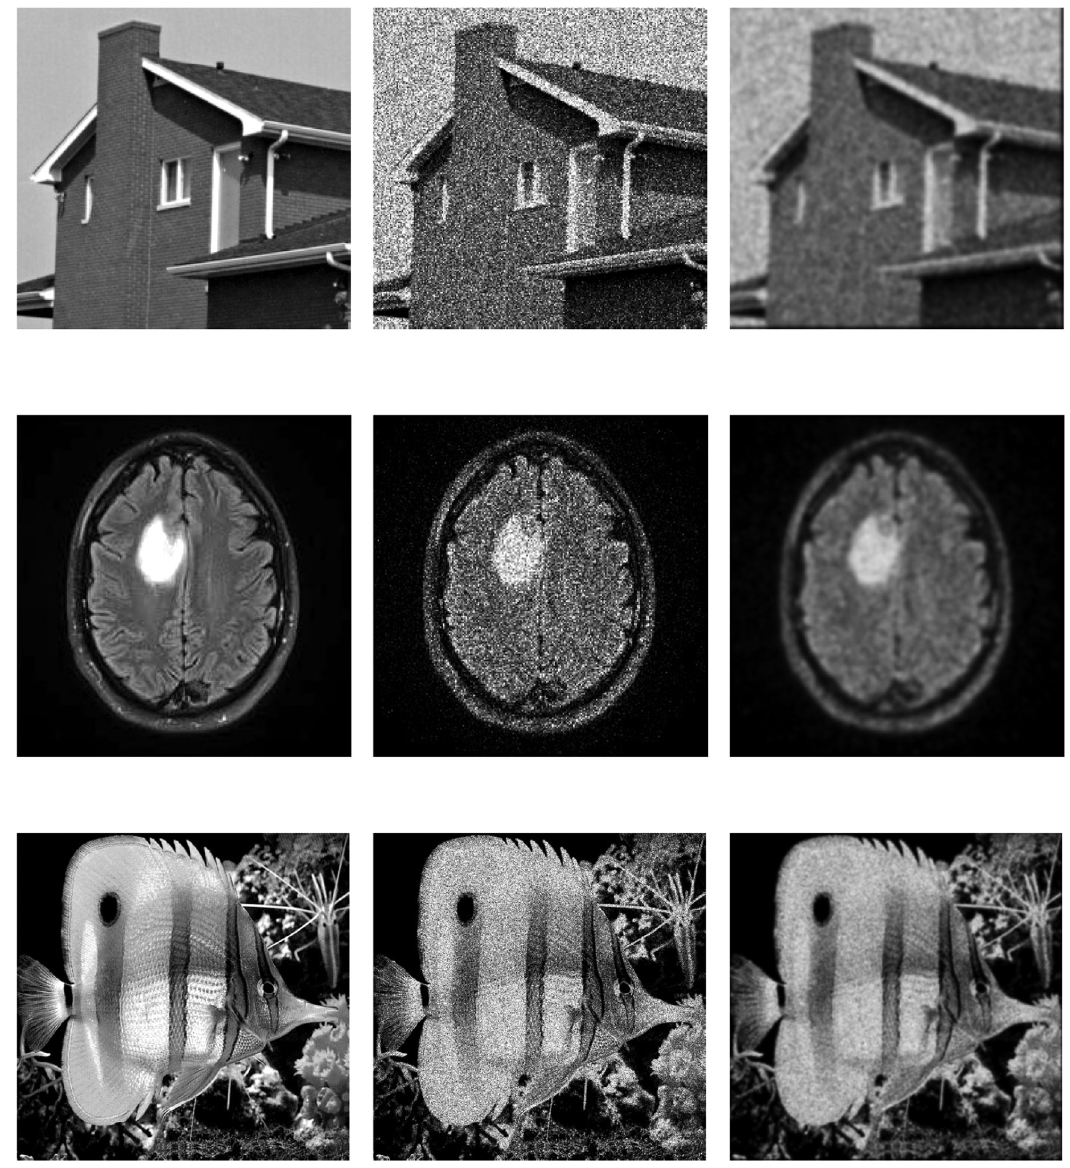
Figure 4: Original images ( left ) , noisy images ( middle ) , and smoothed images ( right )